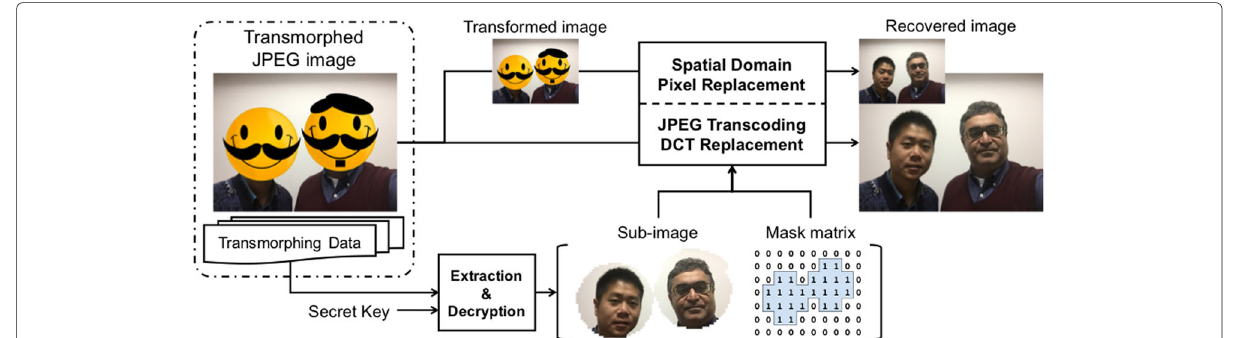
Fig. 6 Recovery of the original from a secure transmorphed JPEG